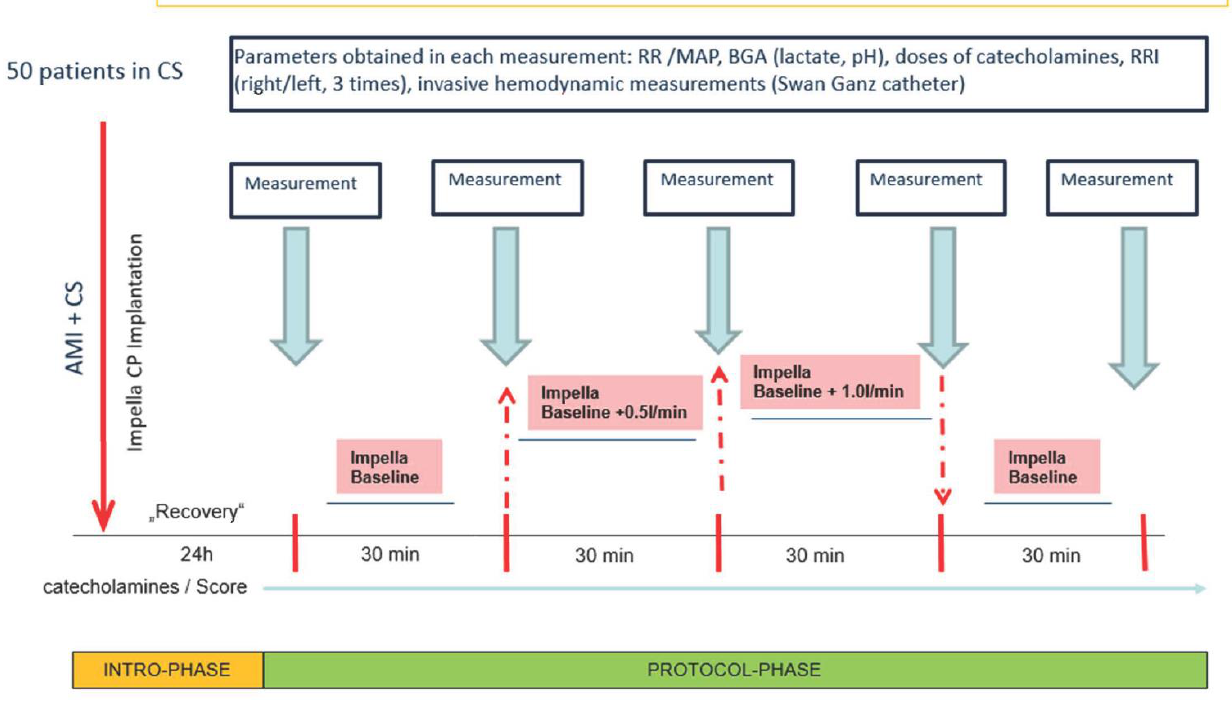
Figure 1. Study design. RR: blood pressure; MAP: mean arterial pressure; BGA: blood gas analysis; RRI: renal resistive index; AMI: acute myocardial infarction; CS: cardiogenic